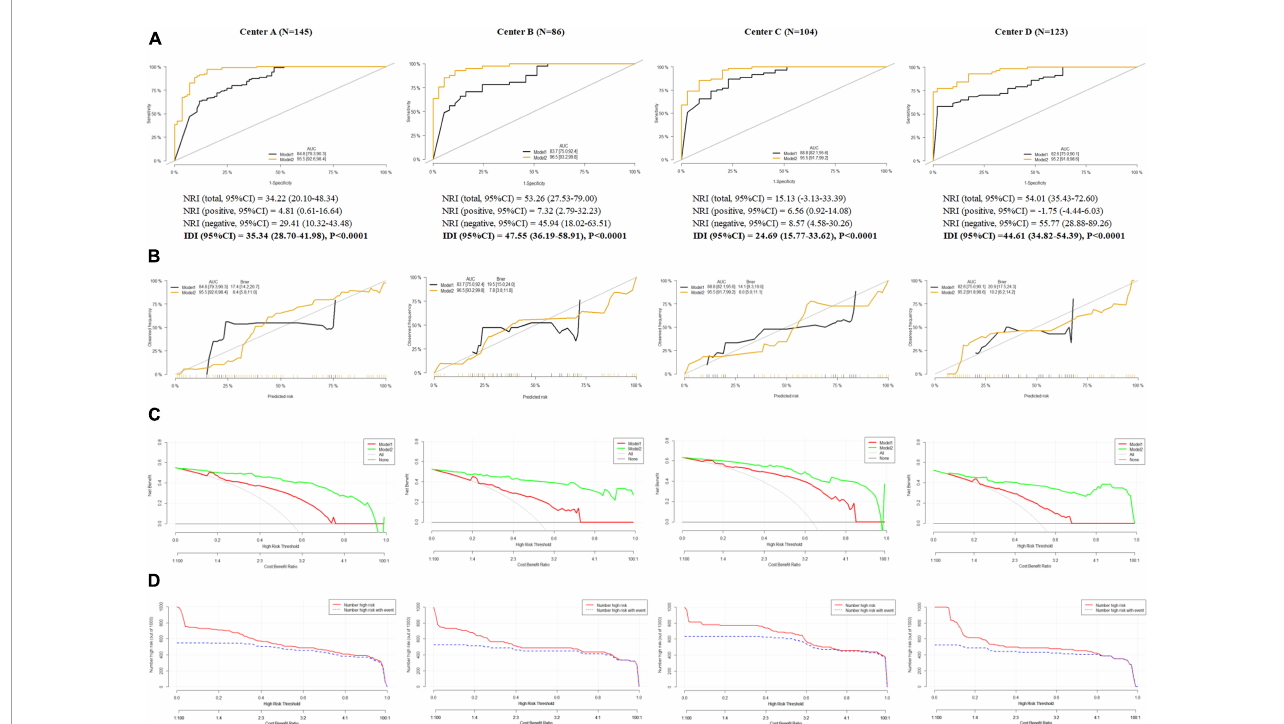
FIGURE4 The comparison of different prediction models (total score vs. cognitive diagnostic probabilities). (A) Area under curve, net reclassification improvement and integrated discrimination improvement in Model 1 and Model 2, (B) calibration curves in Model 1 and Model 2, (C) decision curve analysis in Model 1 and Model 2, and (D) clinical impact curves in Model 1 and Model 2.